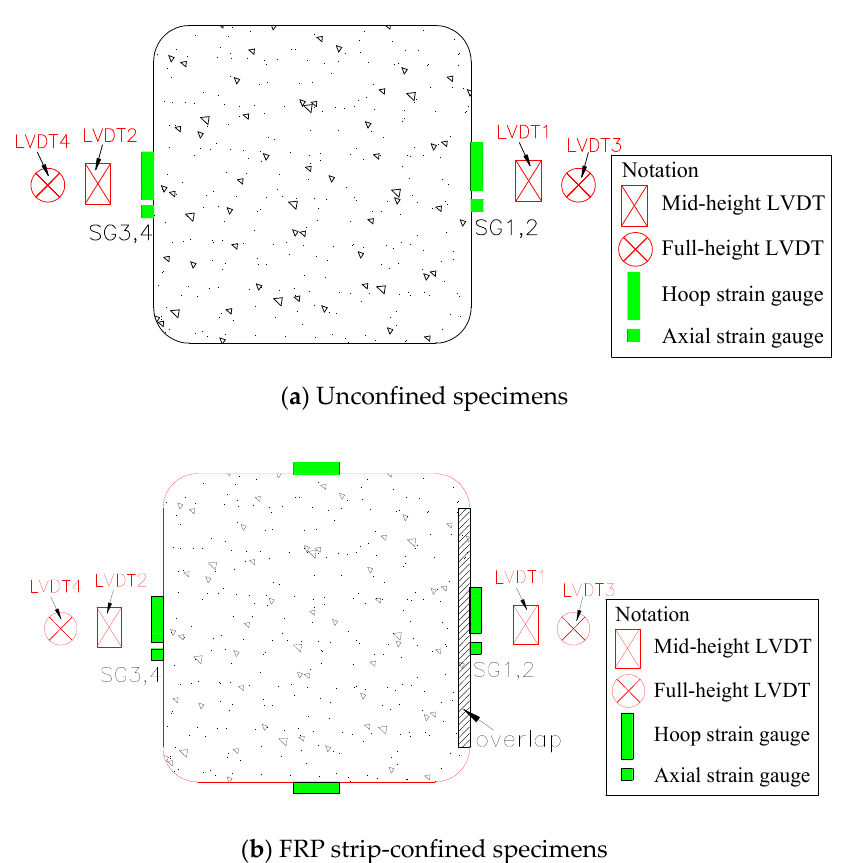
Figure 3. Instrumentations. LVDT = linear variable displacement transducer. SG = strain gauge.